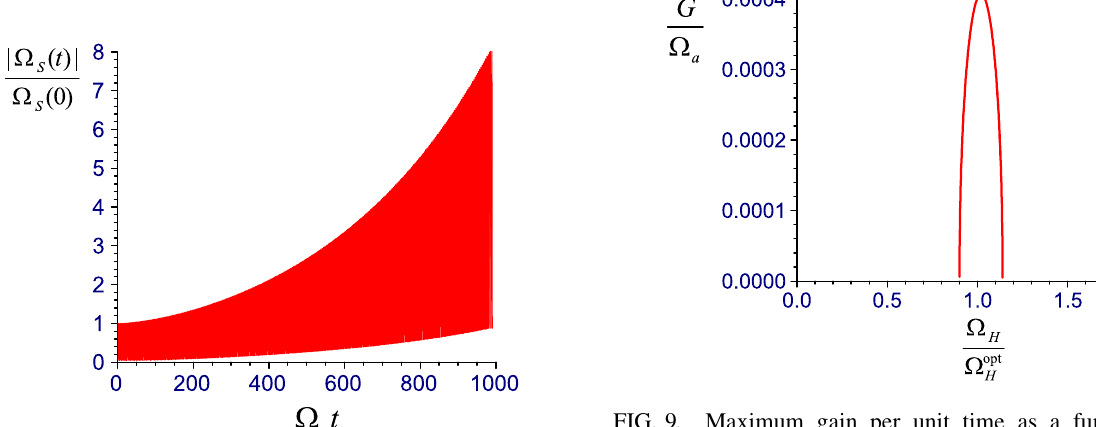
FIG. 9. Maximum gain per unit time as a function of the magnetic field amplitude, which shifts energy of the excited FIG. 7. Evolution of the superradiant pulse as a function of state a and compensates for the time-dependent Stark shift of the a - b transition. Results are obtained by numerical solution of time obtained by numerical solution of Eqs. (B65)–(B71) with ð 0 Þ ¼ 0 , (cid:5) ð 0 Þ ¼ 1 , (cid:5) ð 0 Þ ¼ 0 , ! ¼ 10 : 4(cid:4) ¼ (cid:4) (cid:5) , (cid:4) , Eqs. (B65)–(B69) with ! aa bb ab ab a d a ¼ 0 : 990(cid:4) . and (cid:3) optimum value of (cid:3) d a